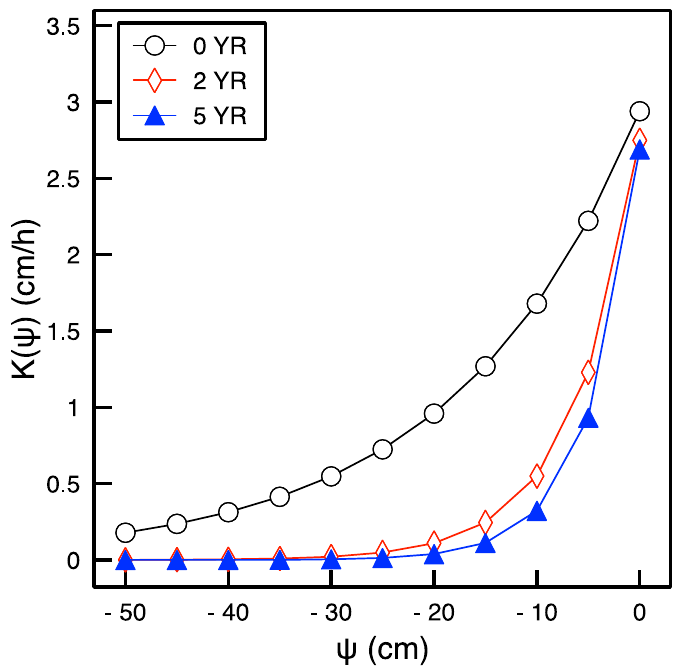
Figure 2. Unsaturated hydraulic conductivity, K, as a function of tension, Ψ, according to the Gardner (1958) model estimated for the three experimental plots with different irrigation treatments (0YR, 2YR, and 5YR).